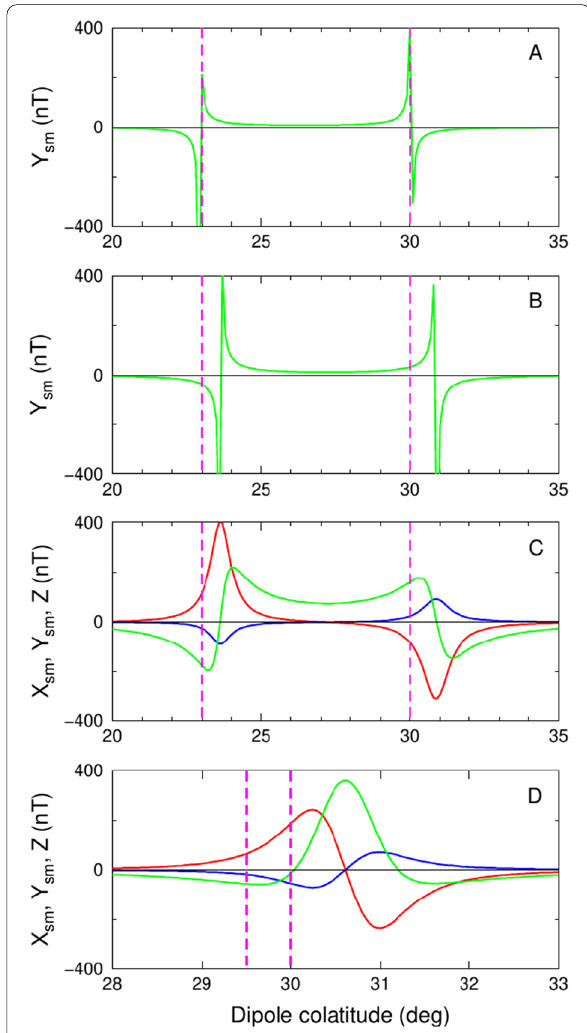
Fig. 7 The magnetic field components X sm (red), Y sm (green) and (cid:31) Z (blue) measured by a satellite vector magnetometer for four hypothetic cases. The vertical dashed violet lines show the position of Region 1 and Region 2. Panel A: A satellite flies in the meridional plane of two semi-infinite long line wires carrying currents of the opposite directions. Panel B: The same as panel A, but the meridional plane contains the down and up field-aligned currents flowing along the field lines of the geomagnetic dipole. Panel C: The same as panel B, but the meridional plane of a satellite orbit is rotated by 2 ◦ from the meridional plane of the currents. Panel D: The same as panel C, but the distance between Region 1 and Region 2 is reduced to 0.5